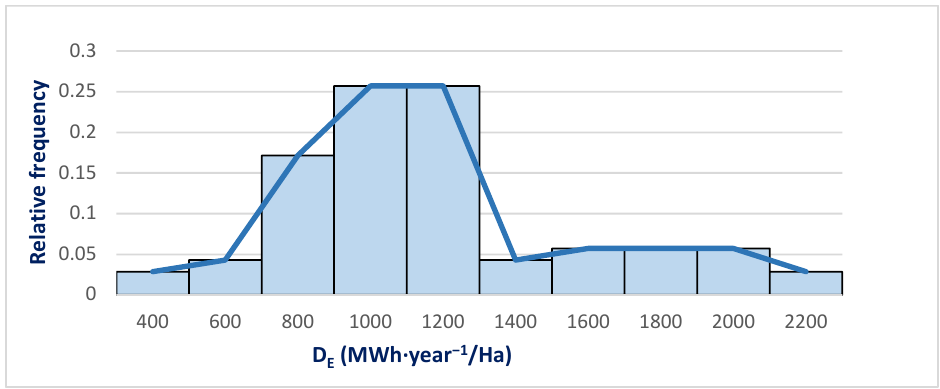
Next, the trend of the indicator D E . (MWh · year − 1 /Ha) is analyzed, which represents the energy density or relationship between the level of energy production of the installation (MWh · year − 1 ) and the area of land that the entire PV installation occupies (Ha). The corresponding histogram (Figure 5) shows that, in more than half of the installations considered (51.42%), this energy density varies between 900 and 1300 MWh · year − 1 /Ha. The distribution of index values for the rest of the cases is homogeneous, with similar relative frequencies, and close to 5% in all cases, except for the classes corresponding to the extreme values of the index (300–500 MWh · year − 1 /Ha and 2100–2300 MWh · year − 1 /Ha) that only occur in 2 of the 70 installations in each case (2.86%).